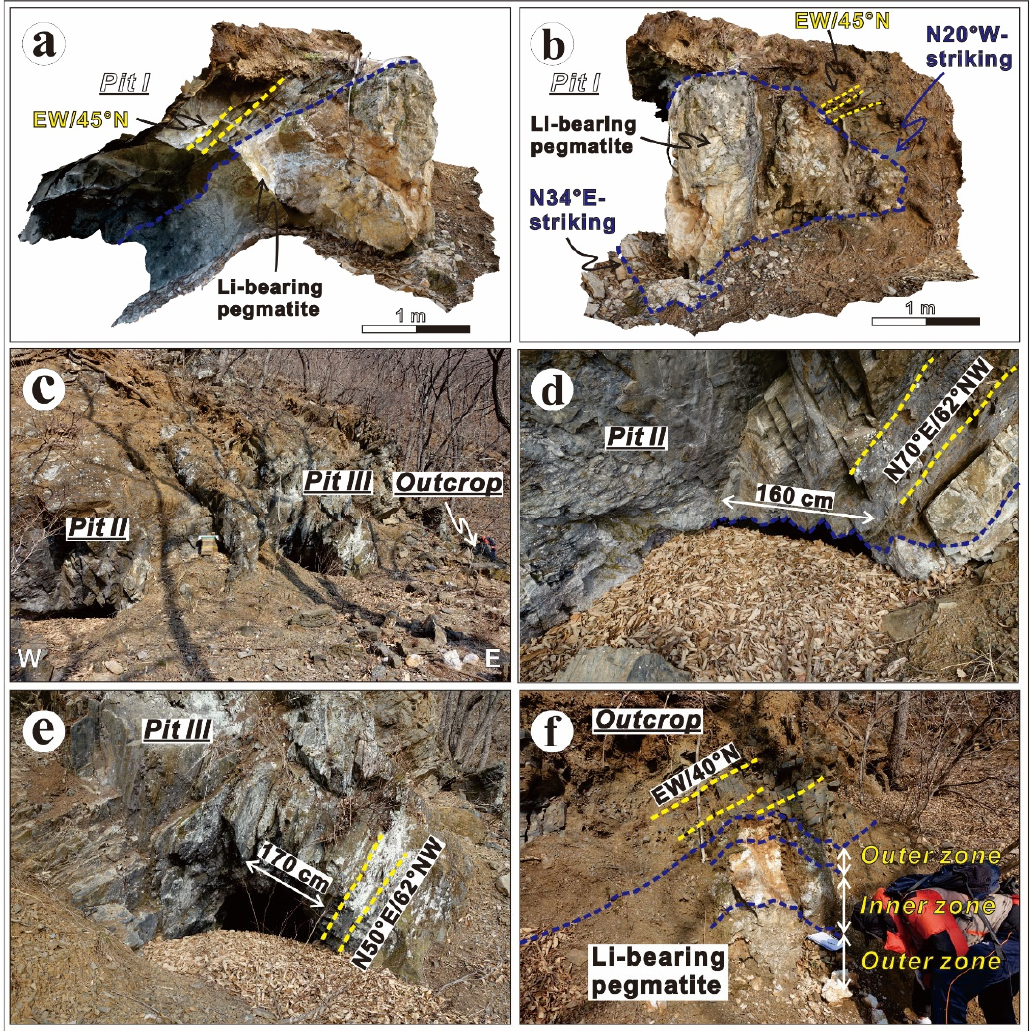
Figure 12. Pit I (Pgt 9), pit II (Pgt 10), pit III (Pgt 11), and outcrop (Pgt 12) of the eastern rare-element pegmatite (REP) bodies. ( a , b ) The long axis of Pgt 9 is parallel to the bedding, while the short axis is lenticular owing to discontinuities and rotation of the bedding. ( c ) Positions of pit II, pit III, and outcrops. ( d , e ) Pgt 10, Pgt 11, and Pgt 12 show the intrusion pattern parallel to the bedding, and the excavation extension of each pit is approximately 10 m (f) Outcrop (Pgt 13) showing the internal zoning.